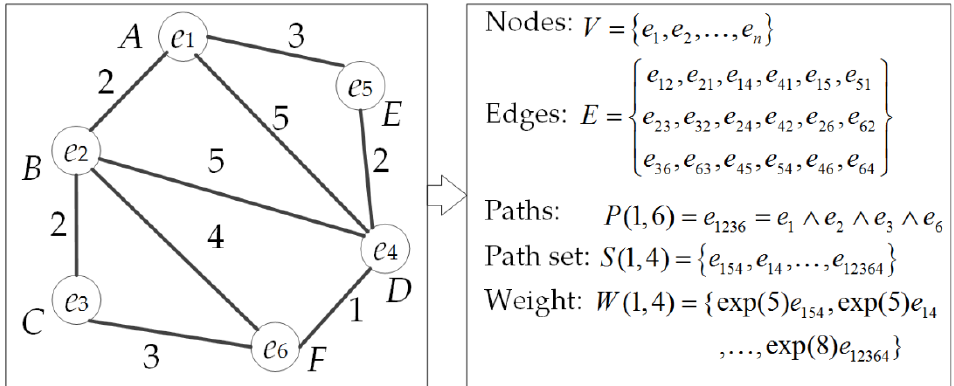
Figure 2. GA-based Network Representation.